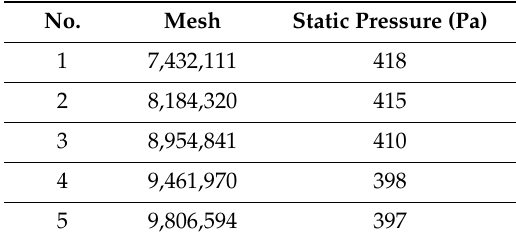
Table 4. Mesh independence verification of the optimized model.